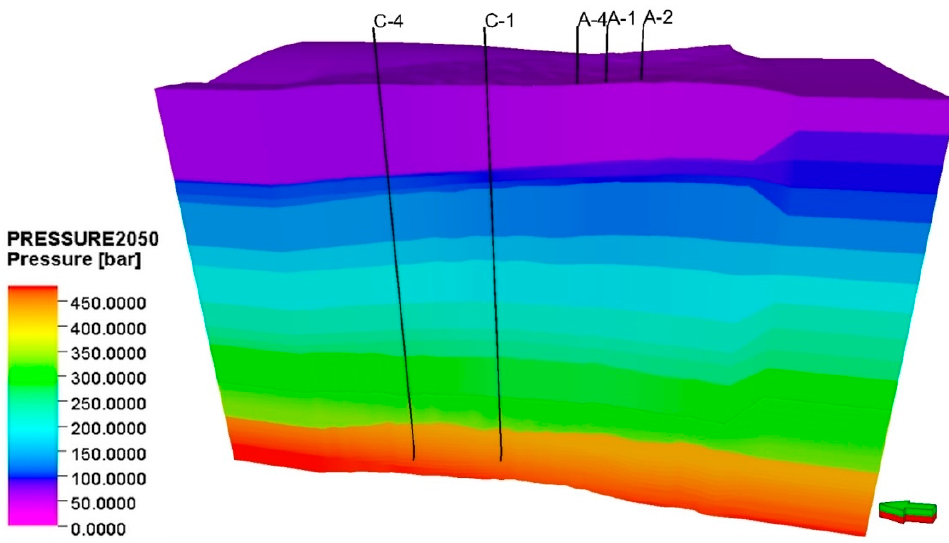
Figure 19. Example of pressure distribution in the analysed structure extended model. Only the reservoir and overburden are shown.